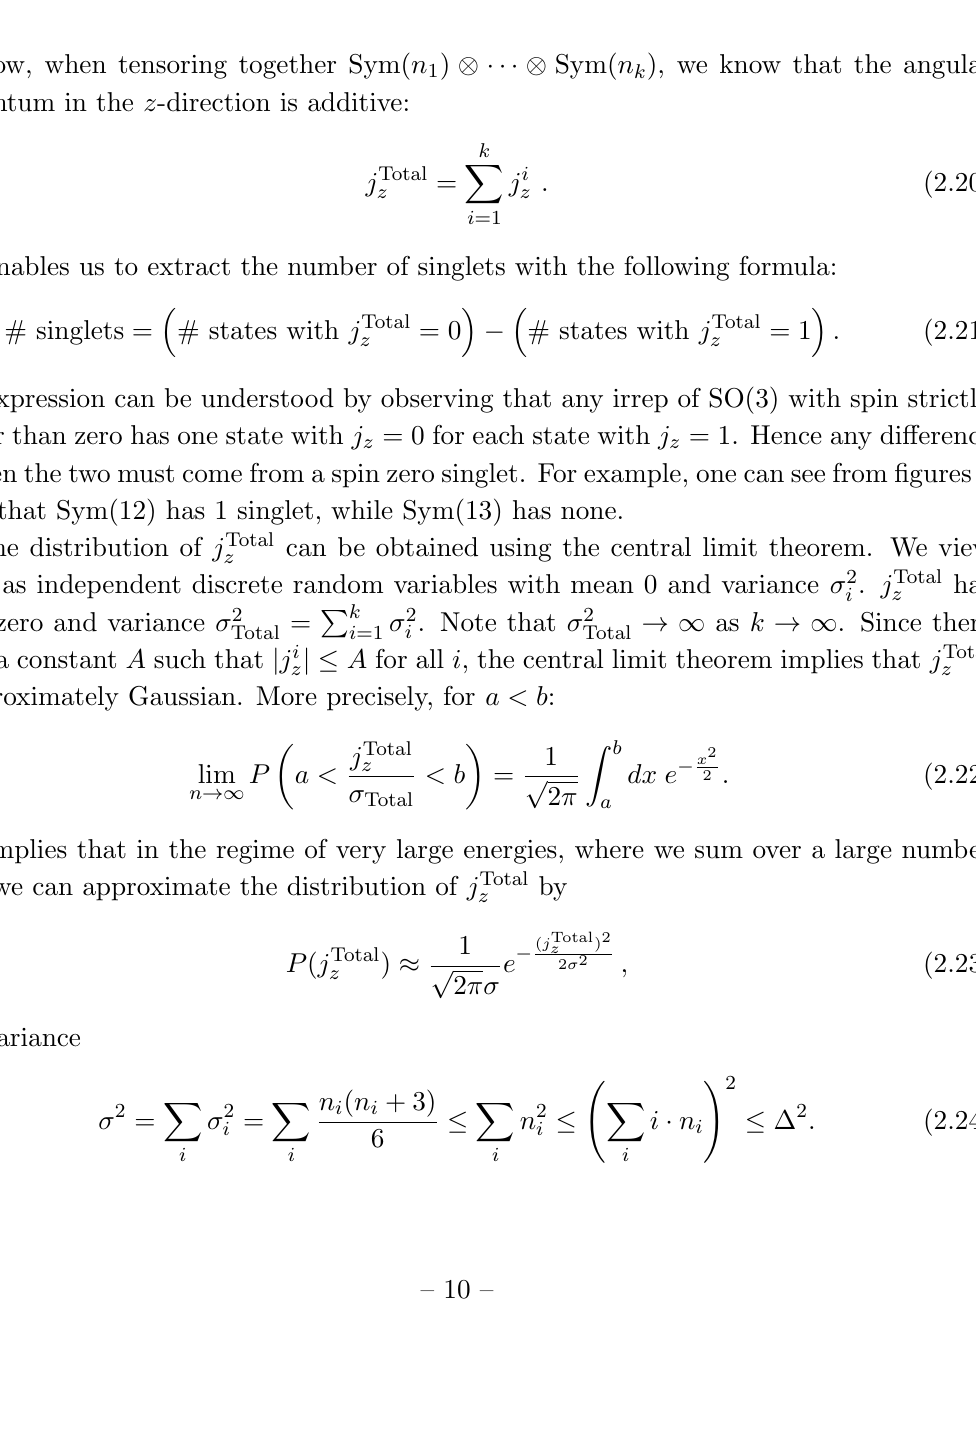
Figure 1 . Distribution of the number of states per j z for Sym(12).